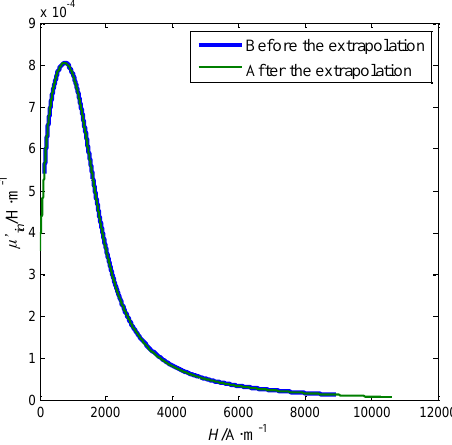
Figure 13. The differential permeability curve before and after the extrapolation.